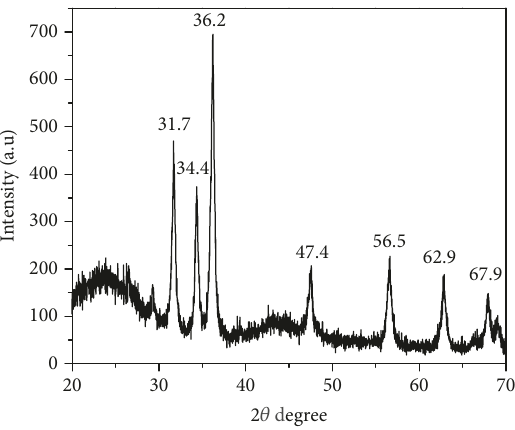
Figure 1: Powder X-ray di ff raction patterns of AC-ZnO.